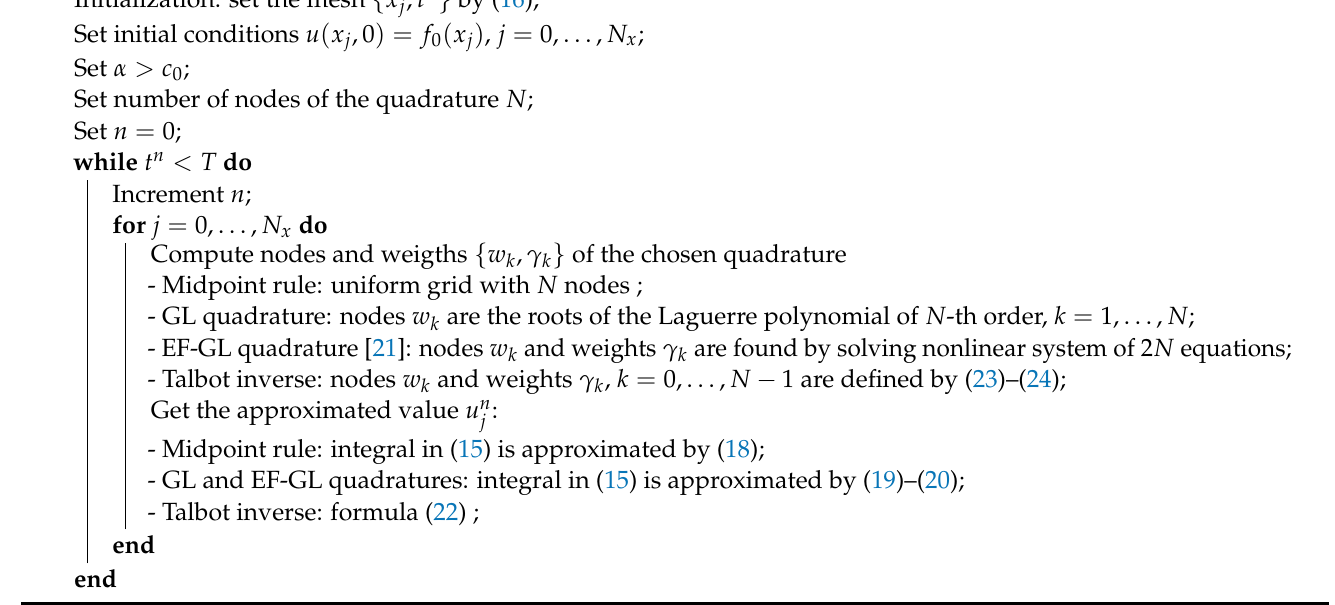
Algorithm 1: Numerical solution for deterministic string vibrating problem